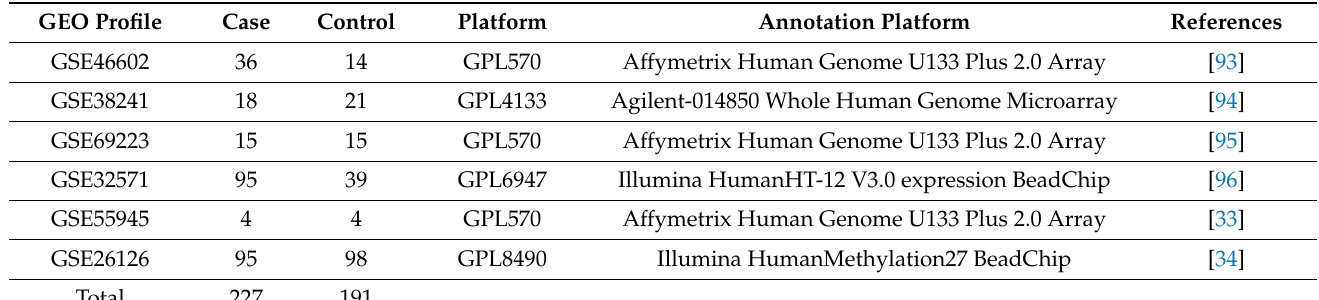
Table 4. Characteristics of the selected GEO microarray dataset profiles associated with